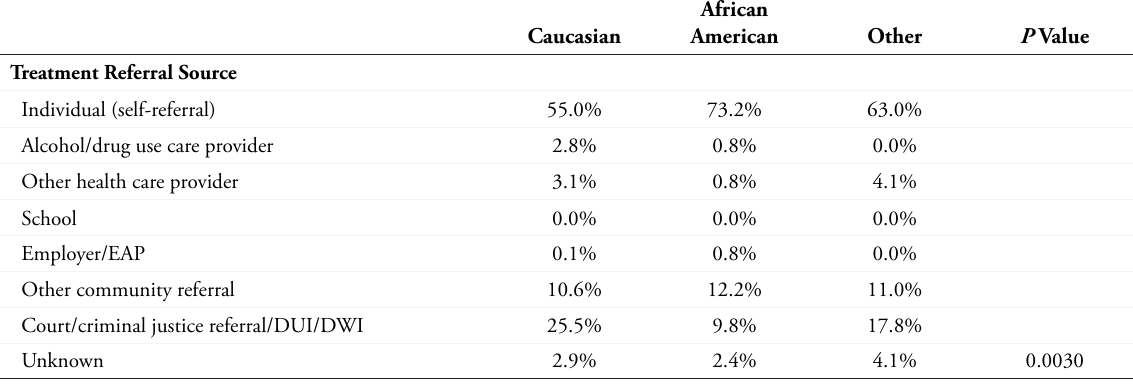
Table 4. Patient Characteristics by Race/Ethnicity for Cincinnati CBSA